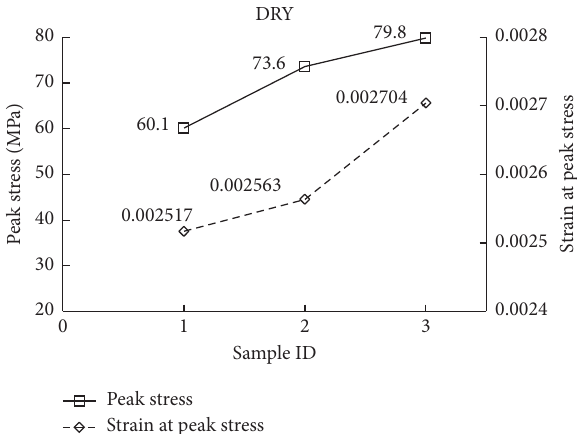
Figure 11: Pattern of the tuffs in the tunnel of Mila Mountain at peak phase under dry condition.